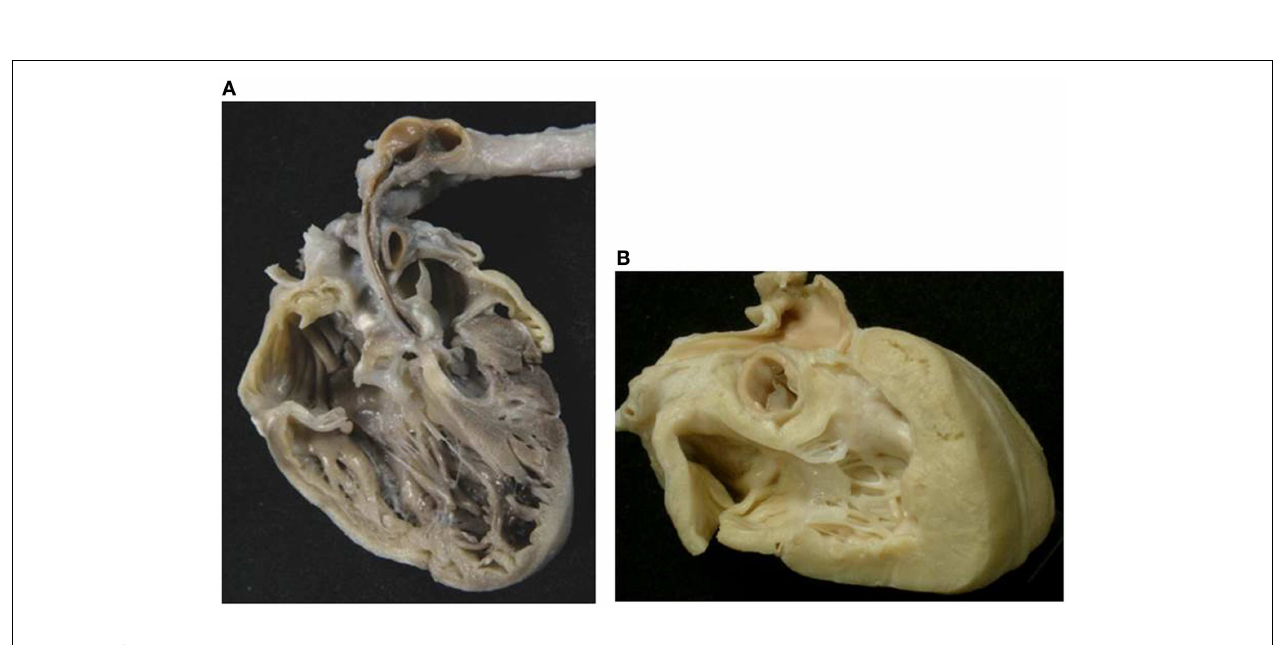
FIGURE 12 | Single outlet ventriculo-arterial connections with functionally univentricular heart . (A) Aortic atresia with intact ventricular septum (single pulmonary outlet). Four chamber echocardiographic cut of the heart showing the severe hypoplasia of the left cardiac chambers. Note the tiny inlet portion of the left